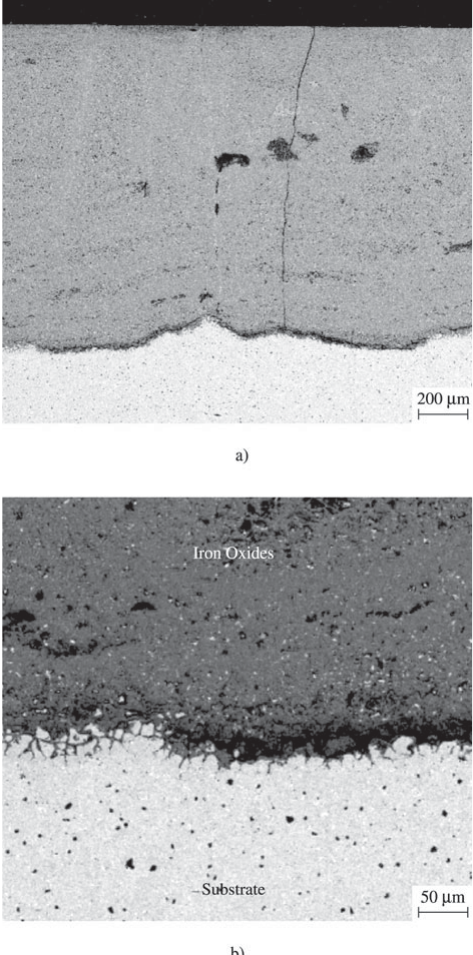
Figure 6. SEM cross-section of the G11 steel sample subjected to the real condition at 650 °C , with different magnifications. a) General view of the sample, showing in detail the fissure in the corroded layer; b) Expanded view, showing the corroded layer/ substrate interface and in detail the internal oxidation and sulfidation of the chromium and the